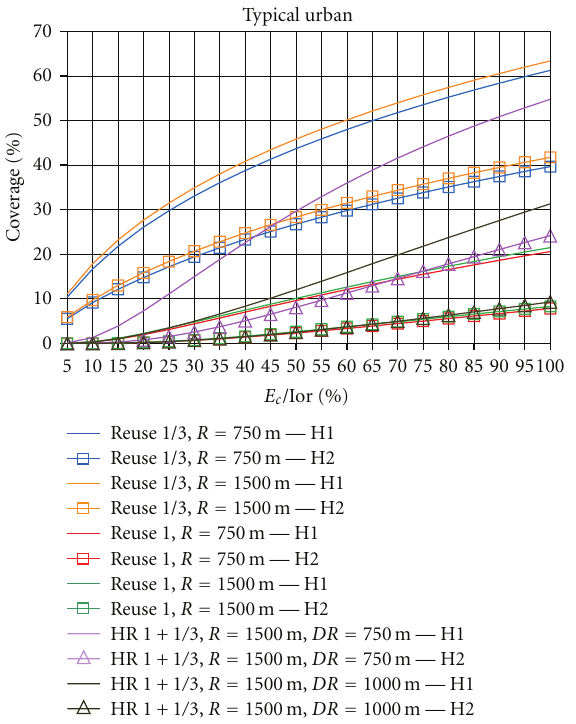
Figure 12: Coverage versus E c /Ior for SC-PTM (2RL) scenario.